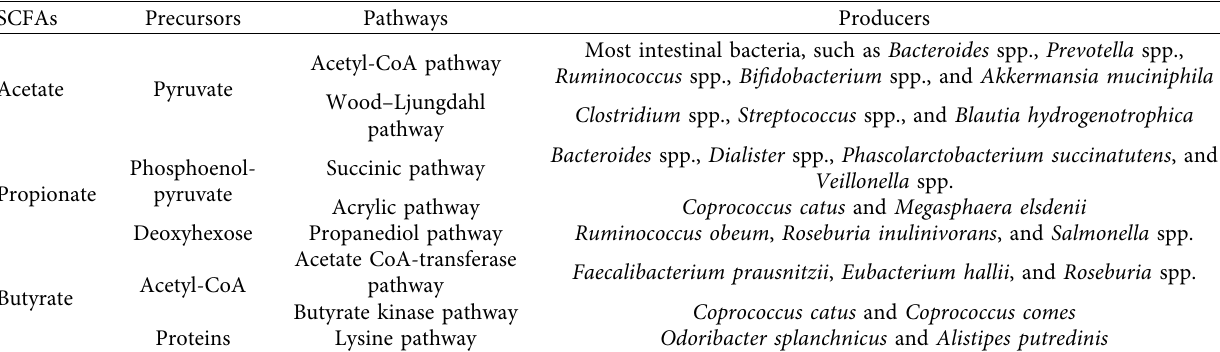
Table 1: Precursors, biosynthetic pathways, and producers of